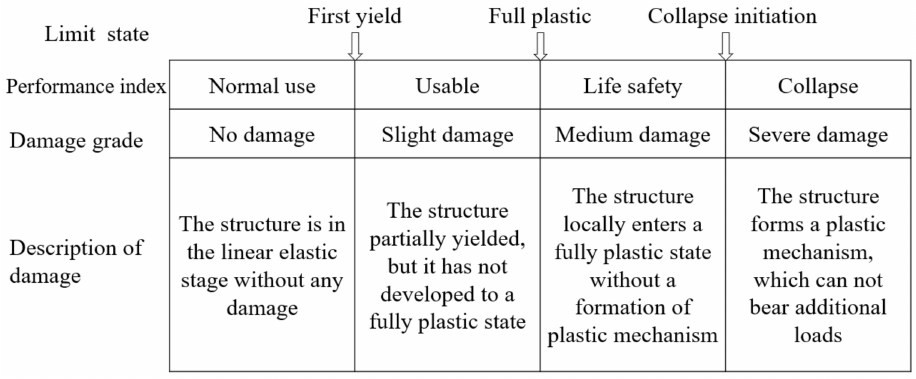
Figure 1. Description of damage grade and damage situation of the